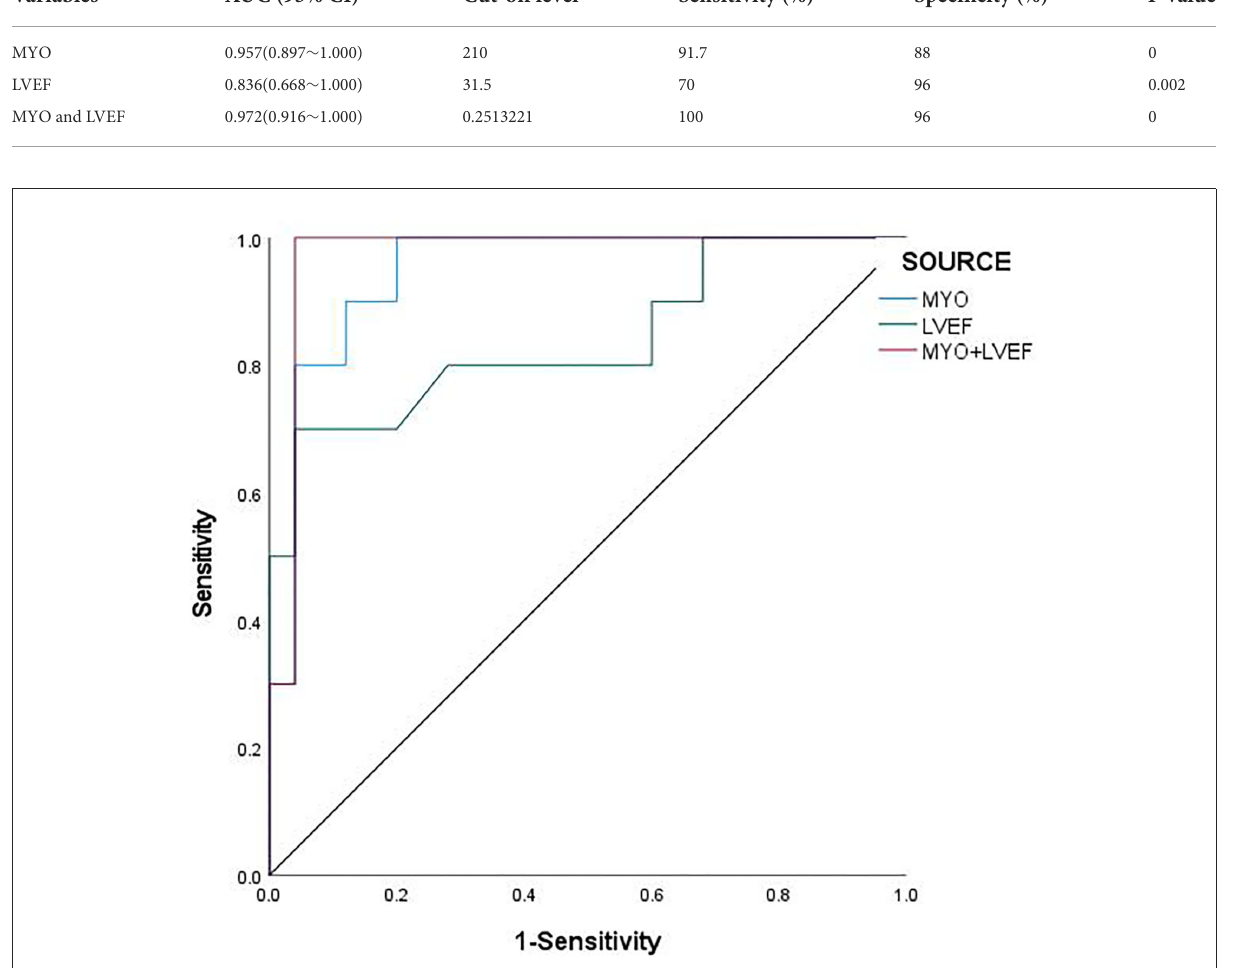
FIGURE2 ROC curves of MYO, LVEF, and their combination predicting death in children with FM.